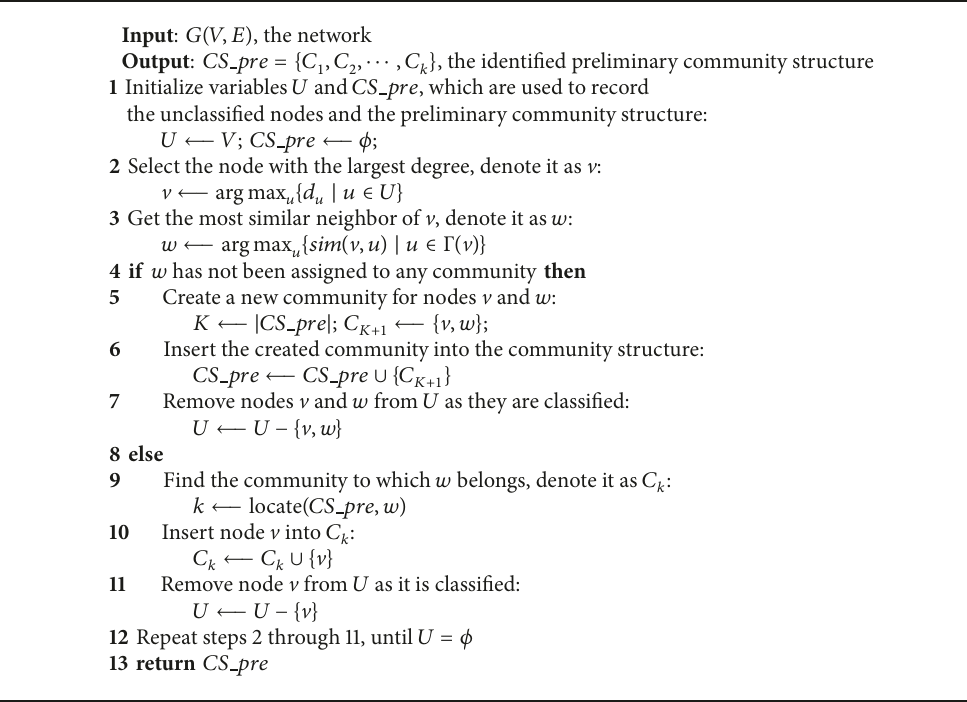
Algorithm 2: FPC(G) : forming the preliminary community